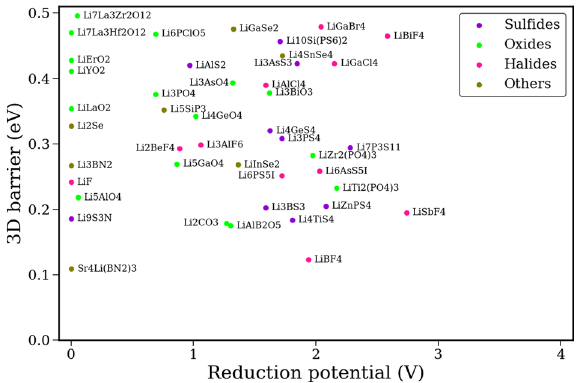
Figure 1. Promising electrolyte and anode coating candidates identified through the screening approach. Complete screening results can be found in Supplementary Figs. S3–S6 and Supplementary Table S1. [3D barrier ≤ 0.5eV , E hull ≤ 30meV , E g ≥ 1eV